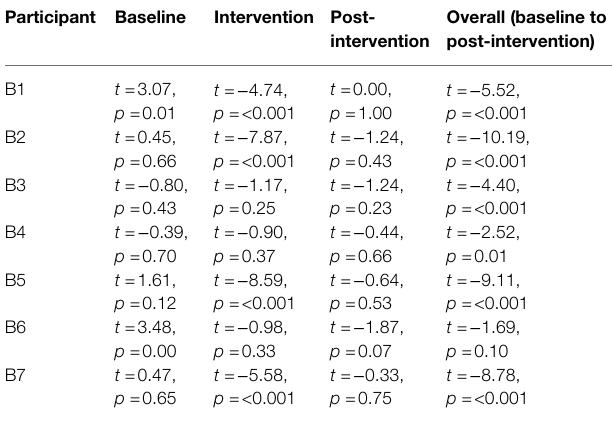
TABLE 2 | Time-series analysis results for participants B1–B7 using Smiling Mind .